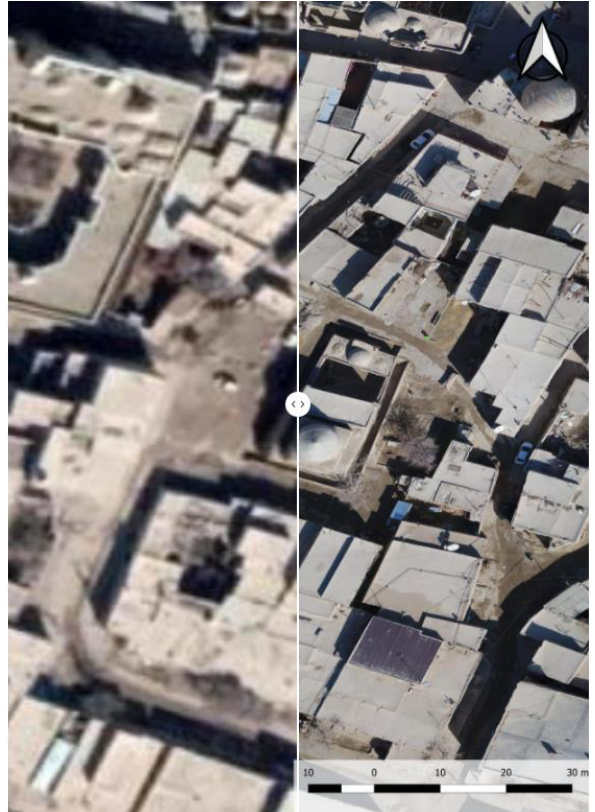
Figure 4 . Aerial images. Google Earth (left) and CAAL Orthophoto – UAV flight altitude: 35m